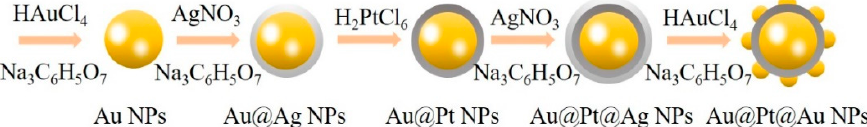
Figure 1. The preparation process picture of Au@Pt@Au core-shell nanoparticles (NPs).